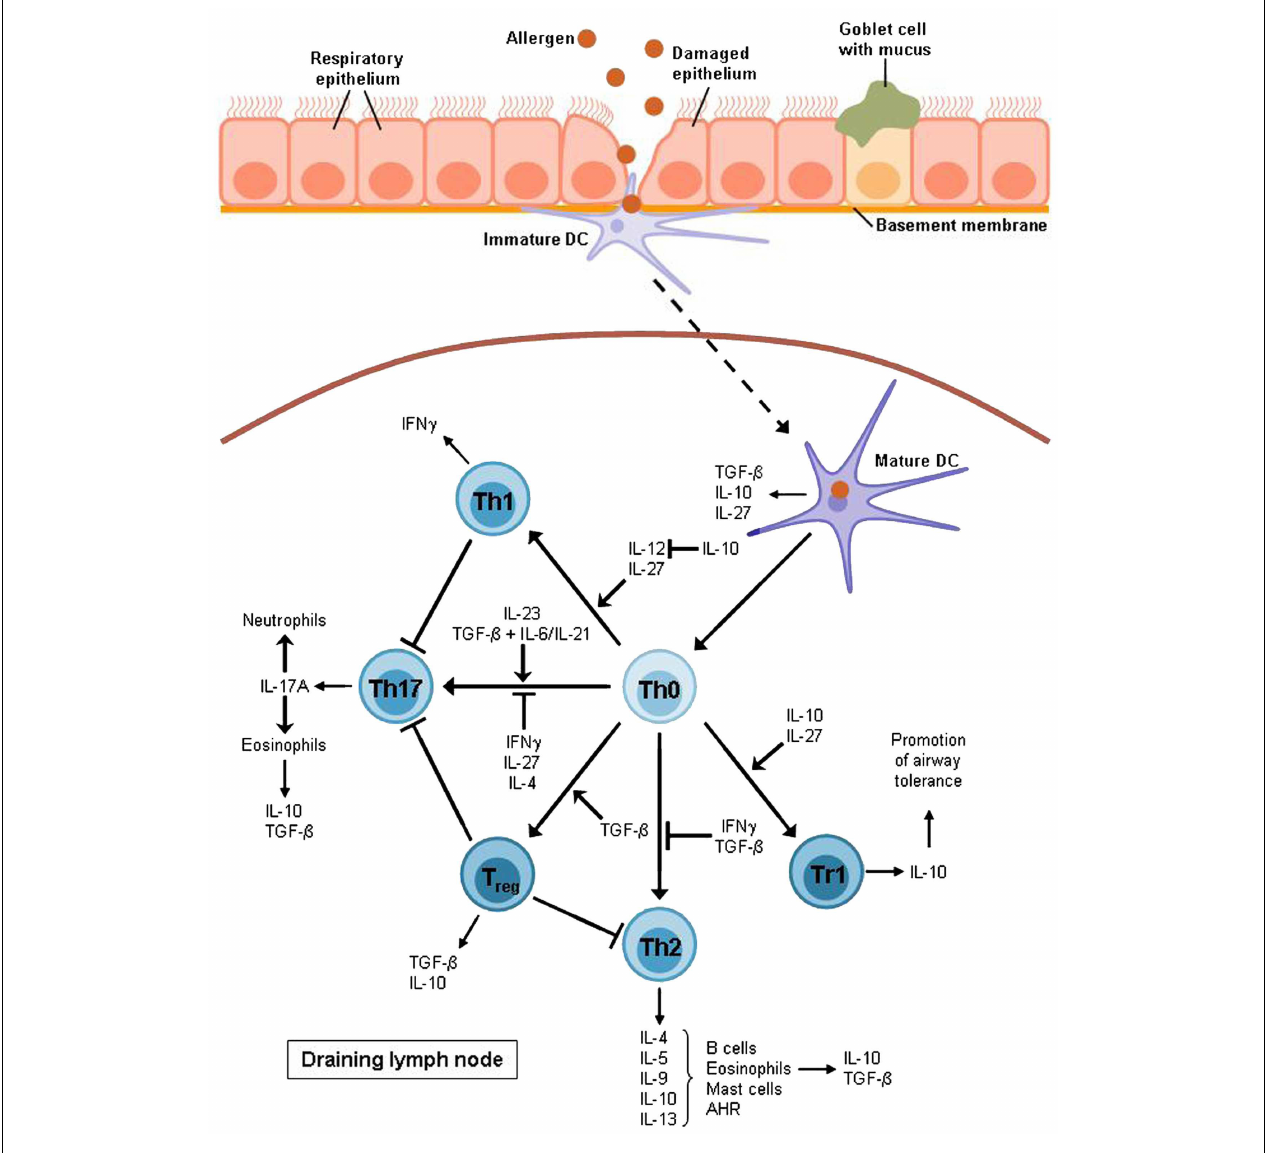
FIGURE 2 |T cell differentiation in allergic asthma. After allergen uptake the DC migrates to the lymph node where it activates naïveT cells to develop into different effector subsets. Allergic asthma has been found to be characterized mostly byTh2 cell expansion and a lack ofTreg cells.Th2 cytokines raise the production of allergen-specific immunoglobulin E (IL-4), support the growth of eosinophils (IL-5) and mast cells (IL-9) and directly cause airway hyperreactivity (AHR; IL-13). Furthermore,Th2 cells produce IL-10 which is also expressed by eosinophils, DCs, andTreg cells,